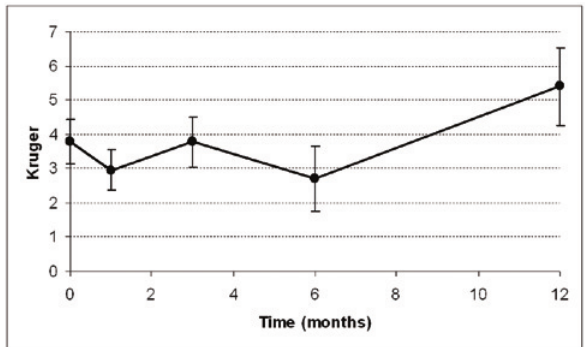
Figure 3 - Variation of Sperm Morphology (Kruger) over time.